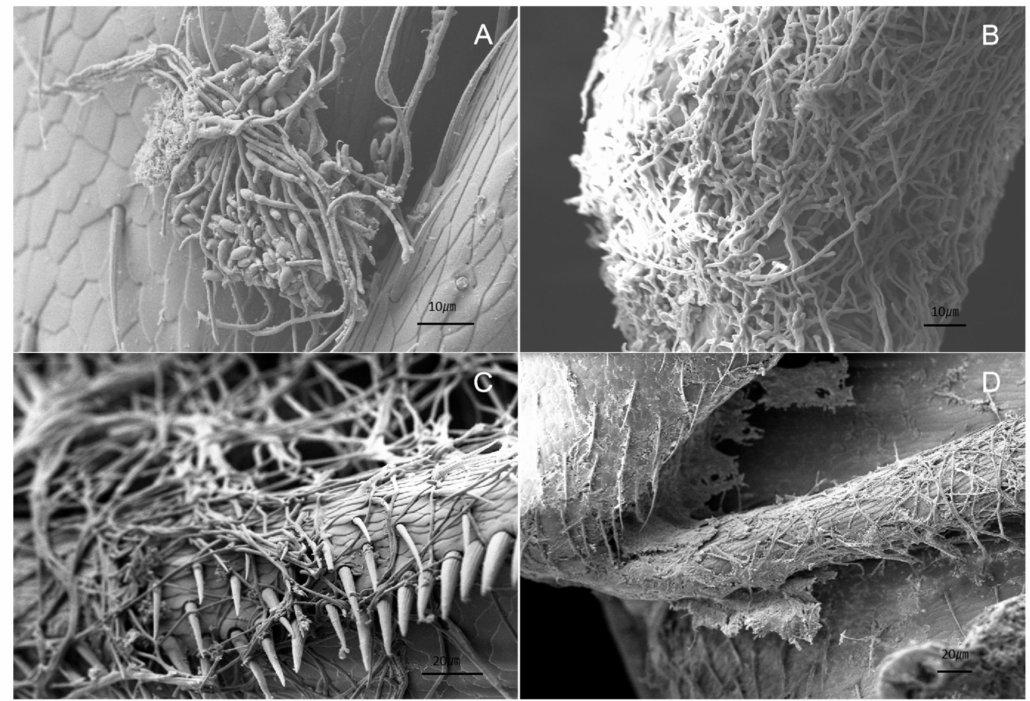
Figure 8. SEM observations of the inoculation of I. javanica for 48–72 h. ( A ) At 48 h, hyphae grew between the foot nodes, and new conidiophores and new conidia were formed. ( B ) At 60 h, conidia germination in vitro produced new hyphae covering the hindfoot. ( C ) At 72 h, the end of the foot was covered with mycelia. ( D ) At 72 h, the hind foot was covered with mycelia.